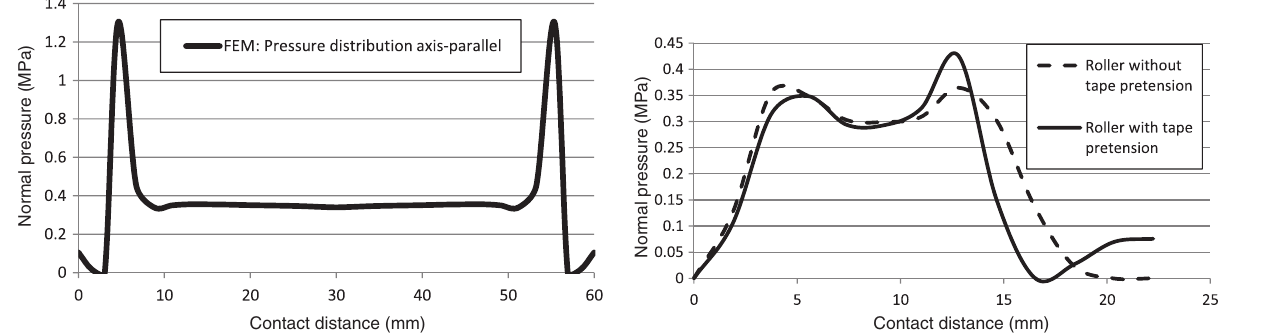
Figure 34 Simulated pressure exaggeration parallel to roller axis due to slit-tape thickness.